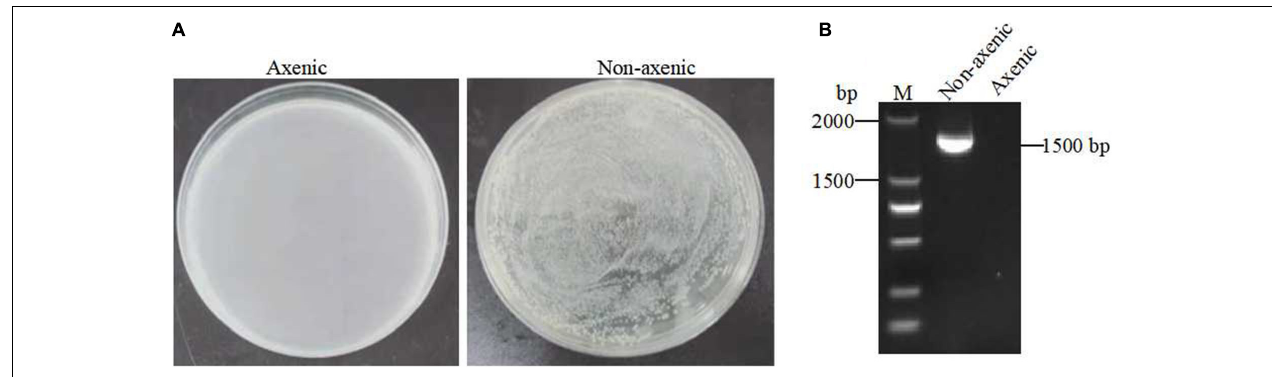
FIGURE 5 | Generation of axenic Spodoptera exigua . (A) The efficacy of eliminating gut cultivable bacteria from non-axenic and axenic S. exigua ( n = 3) gut homogenates on LB agar plates. (B) The efficacy of elimination of gut bacteria by performing PCR analysis on non-axenic and axenic S. exigua ( n = 3) using 16S rRNA gene universal primers